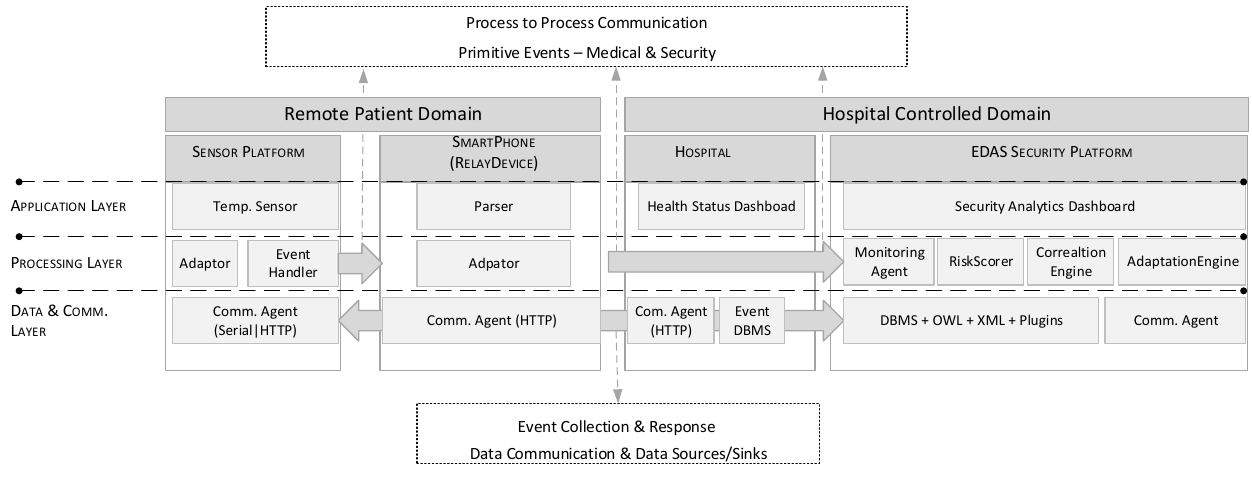
Figure 11. Prototype architecture categorized into functional layers.